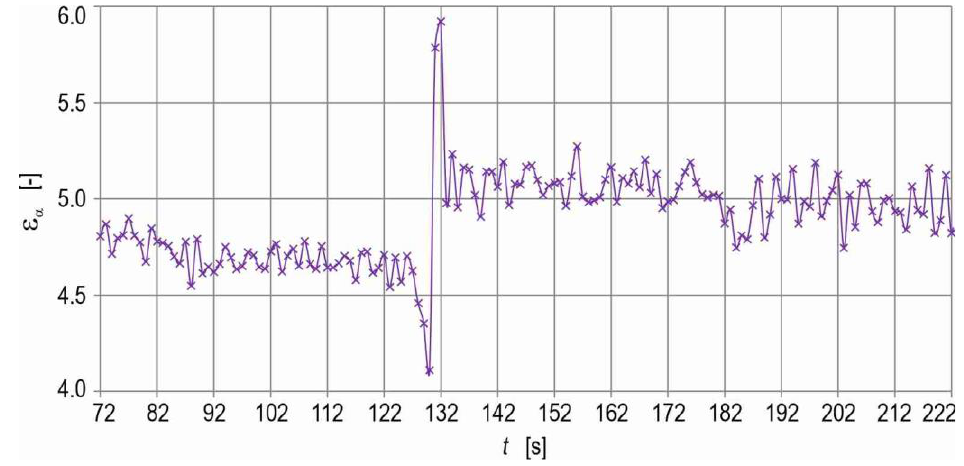
Figure 12. The mean relative error of the heat transfer coefficient as a function of